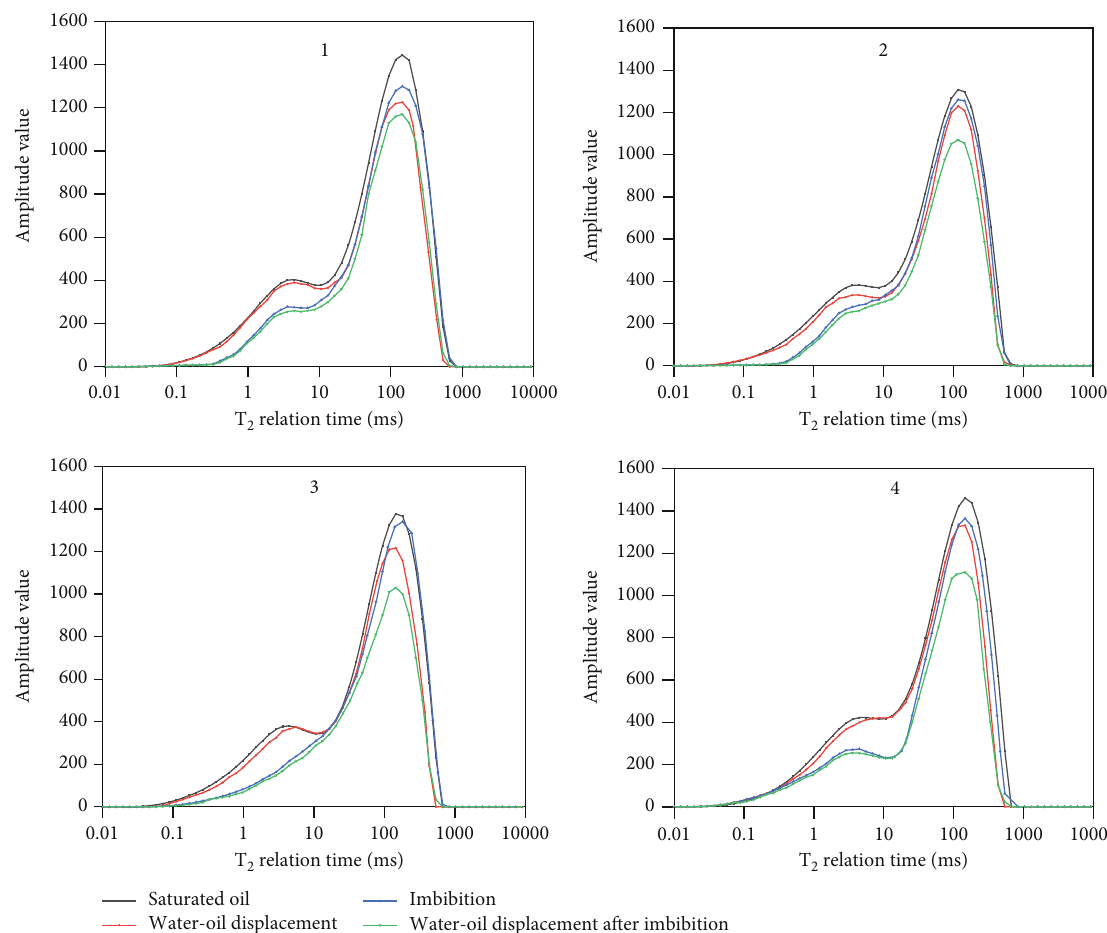
fl ooding oil in di ff erent displacement Figure 3: Comparison of the T 2 curves of the water